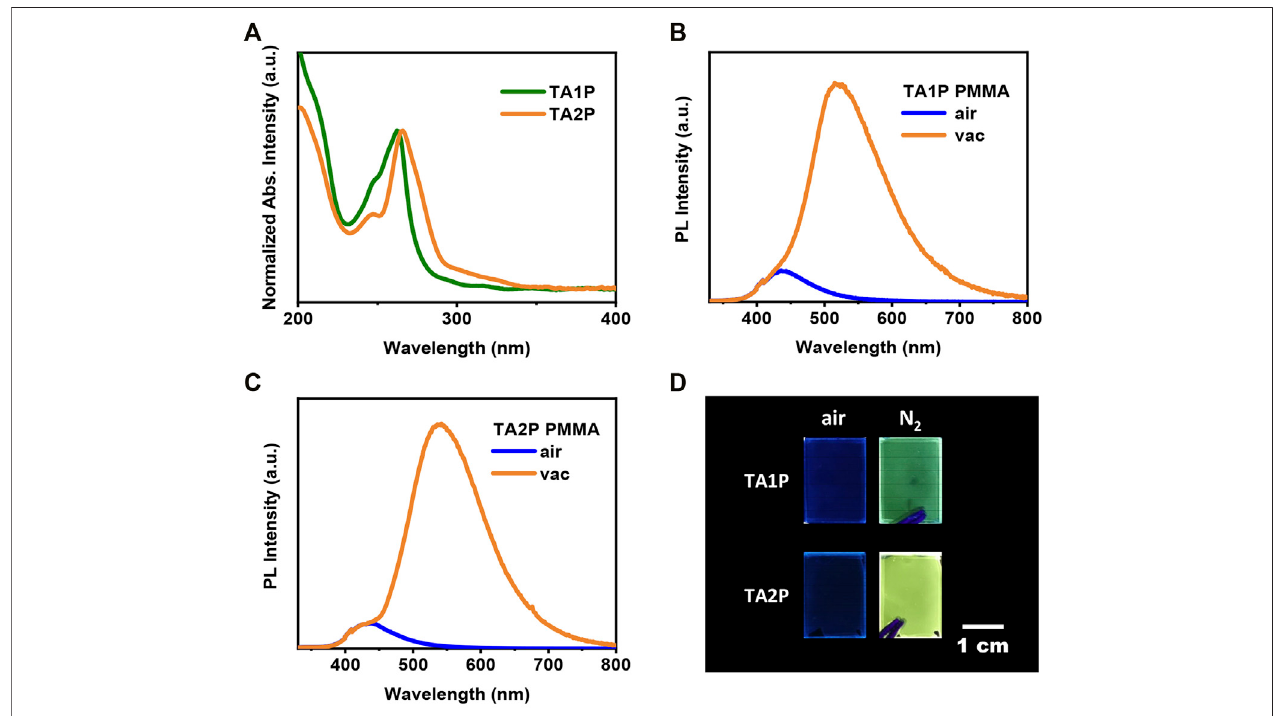
FIGURE 1 | (A) UV-vis absorption spectra of 1-phenylthianthrene (TA1P) and 2-phenylthianthrene (TA2P) polymethyl methacrylate (PMMA) fi lms. (B) , (C) Fluorescence spectra and room-temperature phosphorescence (RTP) spectra of 1 wt.% PMMA-doped fi lms for TA1P and TA2P, respectively. (D) Luminous images of TA1P and TA2P PMMA fi lms in the air and purged by nitrogen (N 2 ).